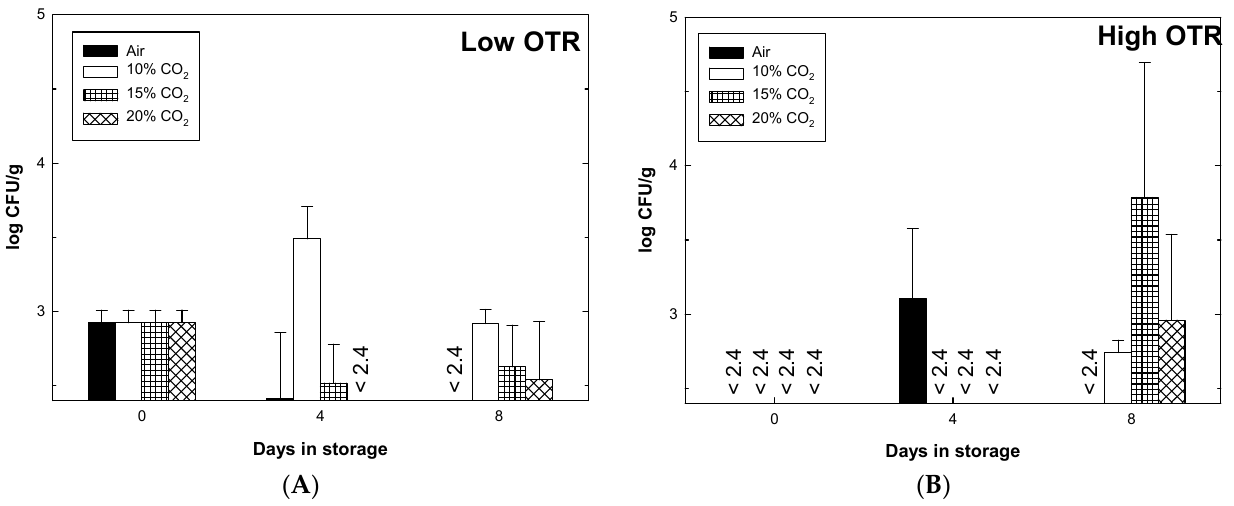
Figure 6. The number of mesophilic bacteria in ‘Pione’ grapes stored in active MAP of high CO 2 (10%, 15%, and 20%) with low-OTR films ( A ) and high-OTR films ( B ) at 10 °C for 8 days. Less than 2.4 log CFU/g means below the level of detection. Vertical lines represent the standard error of the mean ( n = 3). Table 1. Microorganisms isolated from ‘Pione’ grapes before storage and after storage in MA pack- aging flushed with either air or high CO 2 (10%, 15%, and 20%) for 8 days at 10 °C.